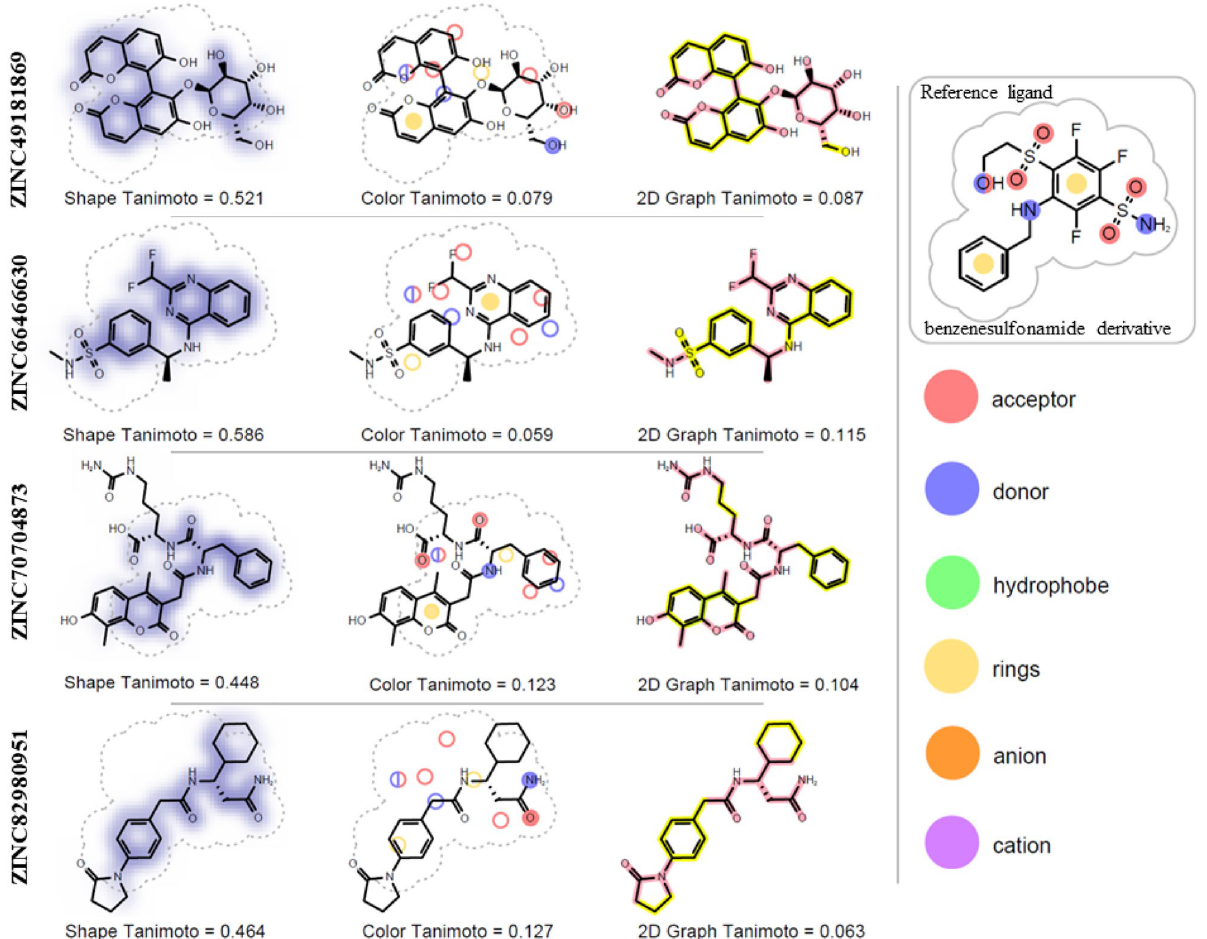
Figure 8. Comparison of the shape and chemical structures of identified compounds with the benzensulfonamide derivative (representative classical inhibitor of hCA XII). Figure was obtained using OpenEye ROCS’s 52 ROCSReport utility (https:// www. eyeso pen. com/